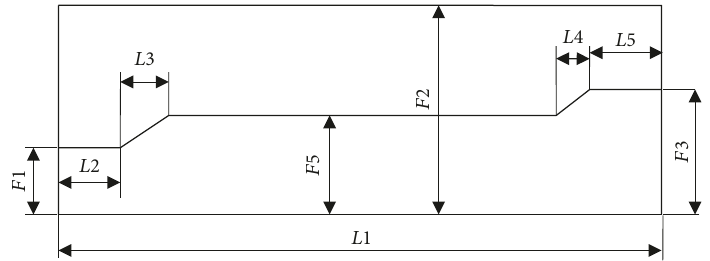
Figure 1: The plan of grain geometry parameters.